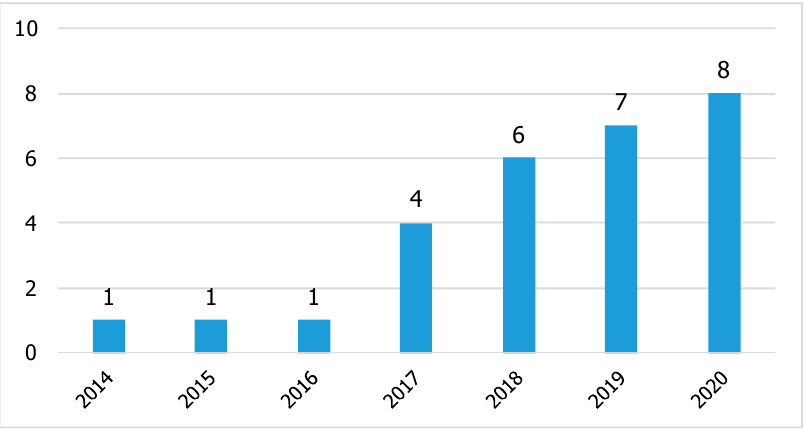
Figure 2. Distribution of papers over time.